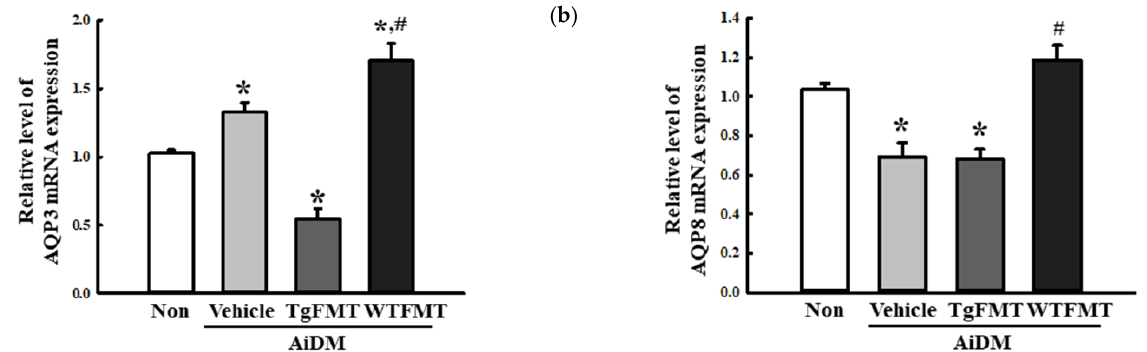
Figure 8. Expression levels of the AQPs in AiDM+TgFMT mice. The relative levels of AQP3 ( a ) and AQP8 ( b ) transcripts of the total mRNA from mid-colons were measured by RT-qPCR analyses using specific primers. The mRNA levels of the two genes were represented as the relative level of the intensity of β -actin. The total RNA was prepared from three to five mice per group, and RT-qPCR analyses were performed in duplicate. The data are reported as the mean ± SD values. *, p < 0.05 compared to the Non-treated group. #, p < 0.05 compared to the AiDM+Vehicle group. Abbreviation; WT, wild type; Tg, Tg2576 mice; FMT, Fecal microbiota transplantation; TgFMT, Tg2576 mice FMT; WFMT, Wild type mice FMT; AiDM, Antibiotics-induced depletion of microbiota.